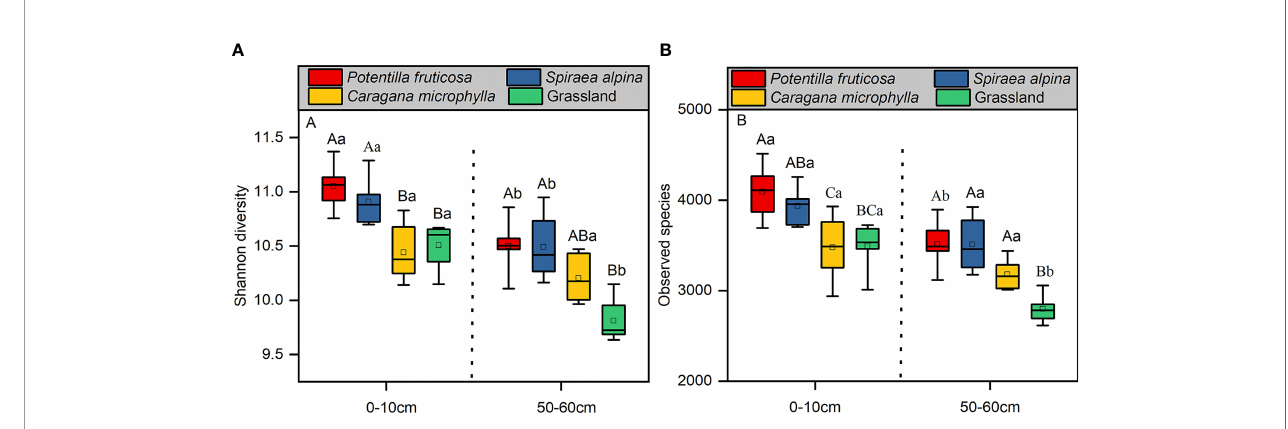
FIGURE 4 | Soil bacterial alpha-diversity (A) Shannon diversity; (B) Observed species. Different lowercase letters indicate signi fi cant differences between the different soil layers within the same vegetation types ( p < 0.05, independent-samples t-test). Different uppercase letters indicate signi fi cant differences between the different vegetation types within the same soil layers ( p < 0.05, Tukey ’ s HSD test).